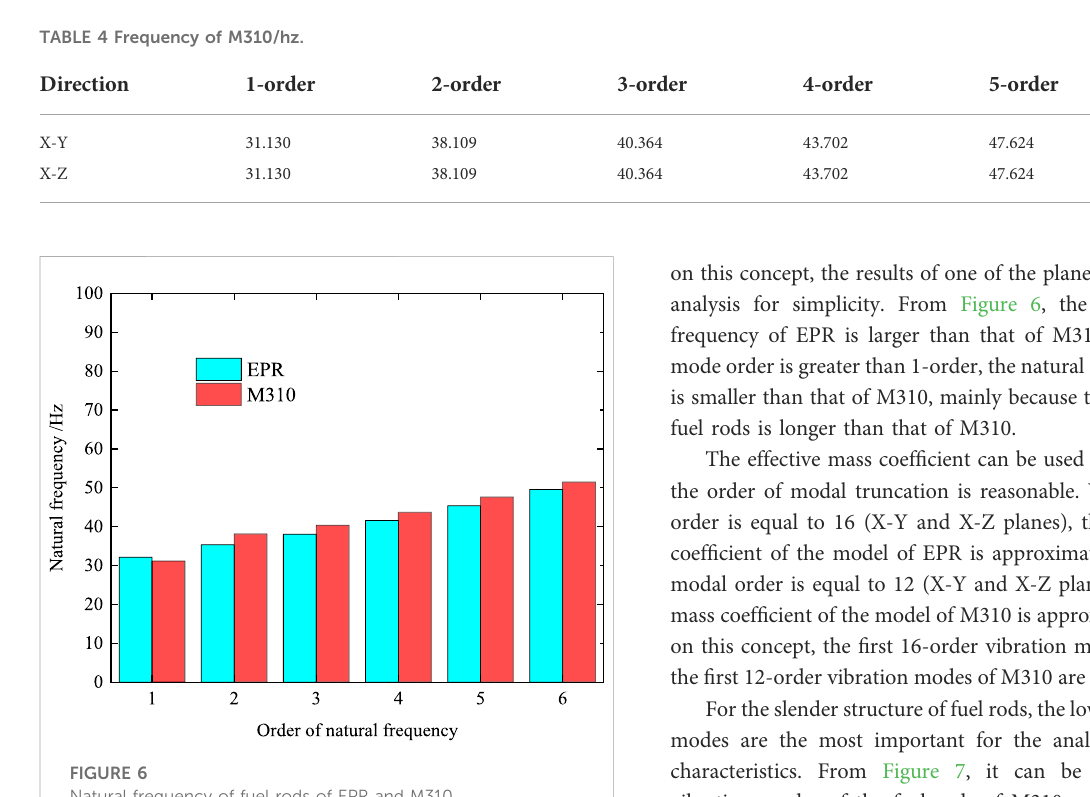
FIGURE 6 Natural frequency of fuel rods of EPR and M310.